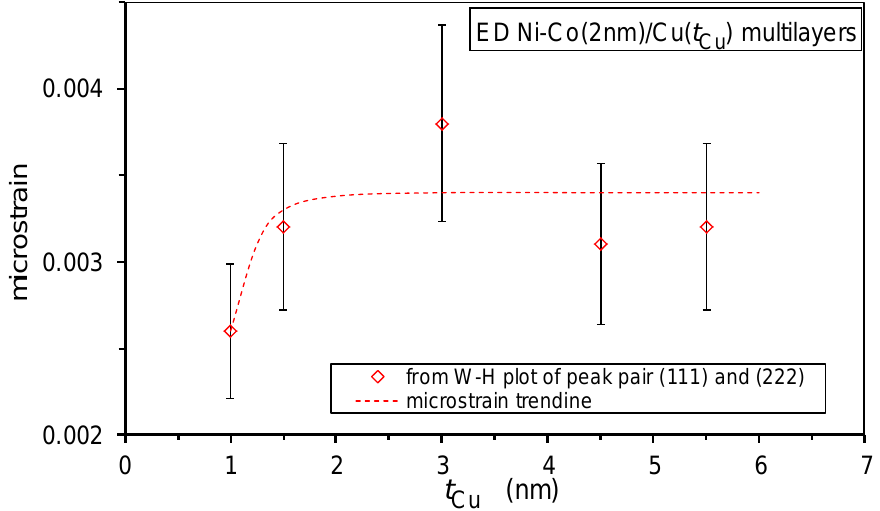
Figure 9. Microstrain for the present Ni65Co35/Cu multilayers as derived from the W–H plots (open diamond symbols; the dashed line is just an estimated trendline).